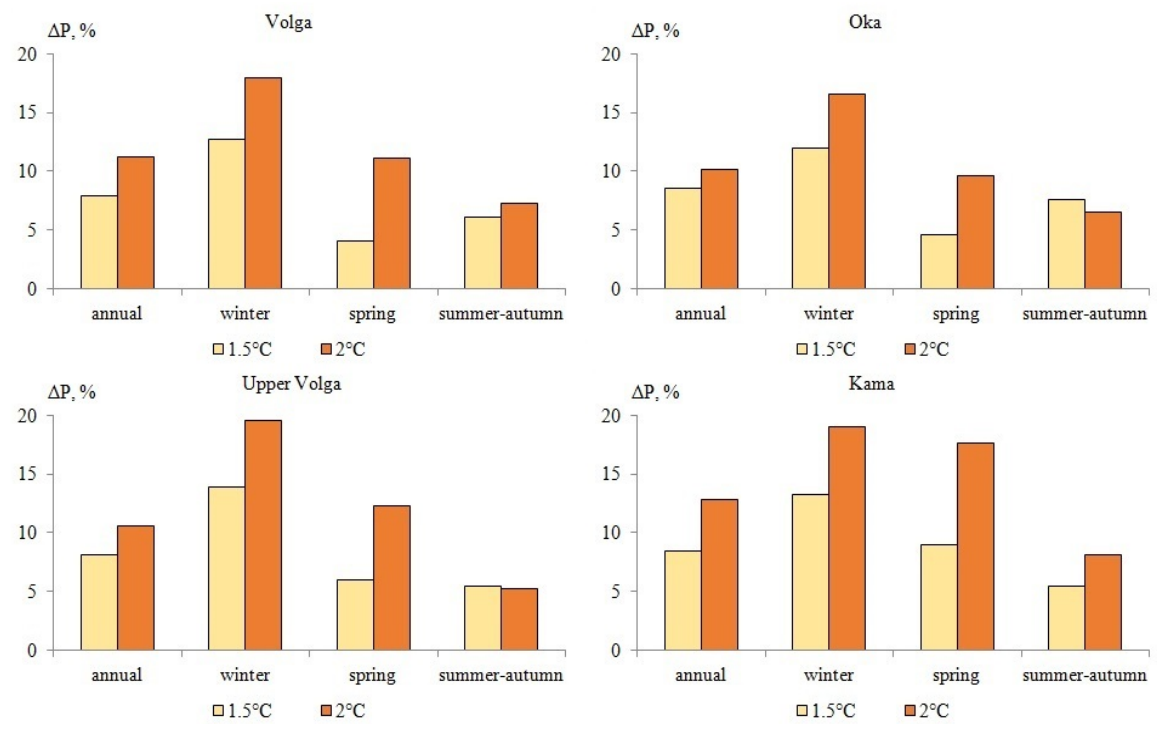
Figure 6. Anomalies of mean annual and seasonal precipitation in the Volga basin under global warming by 1.5 ◦ C and 2 ◦ C in the 21st century relative to the baseline period 1970–1999. According to the 1.5 ◦ C global warming scenario, the most intensive increase in